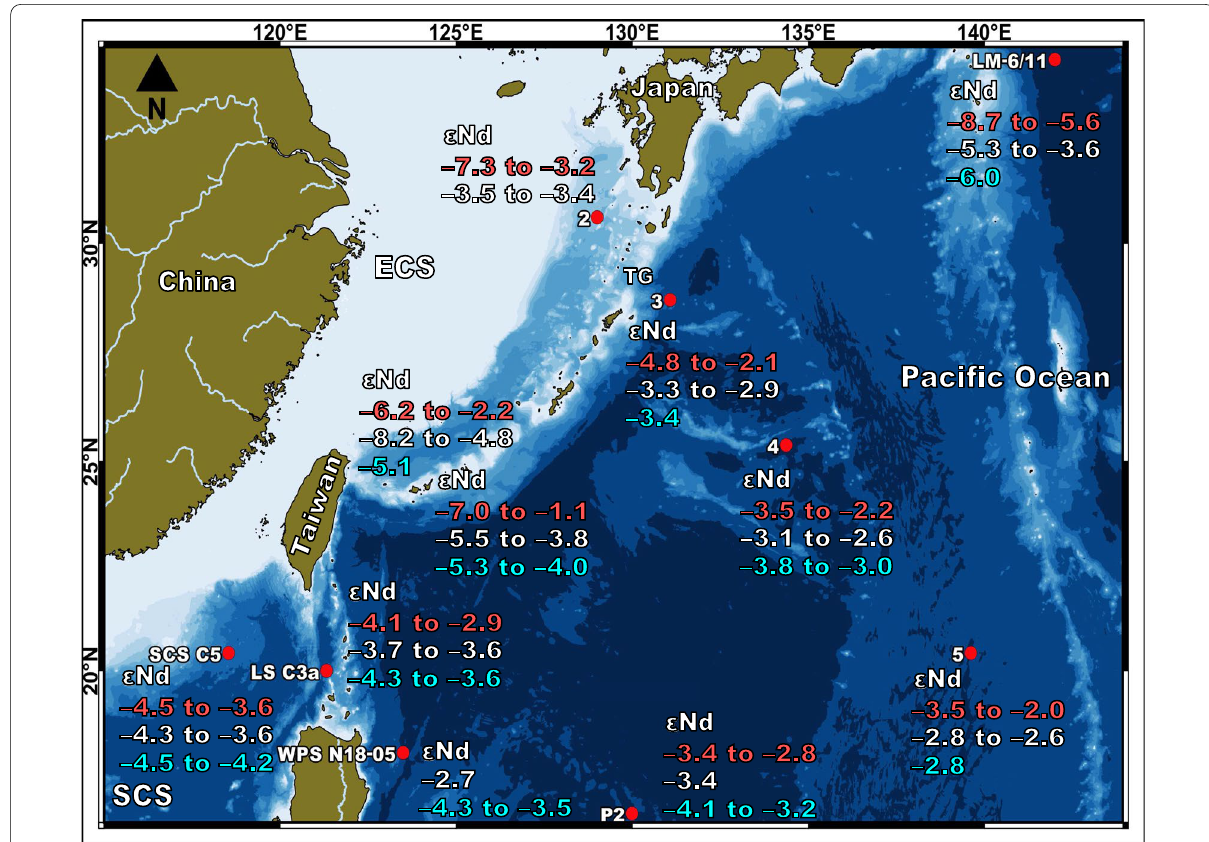
Fig. 6 εNd values of surface–subsurface (red), intermediate (white), and deep (light blue) waters in the Philippine Sea and the northeastern part of the South China Sea. Data from Amakawa et al. (2004b), Wu (2014) and Behrens et al.